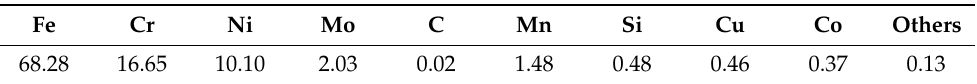
Table 3. Composition of 316L stainless steel (weight percentages) purchased from the company Metals Samples A Division of Alabama Specialty Products,